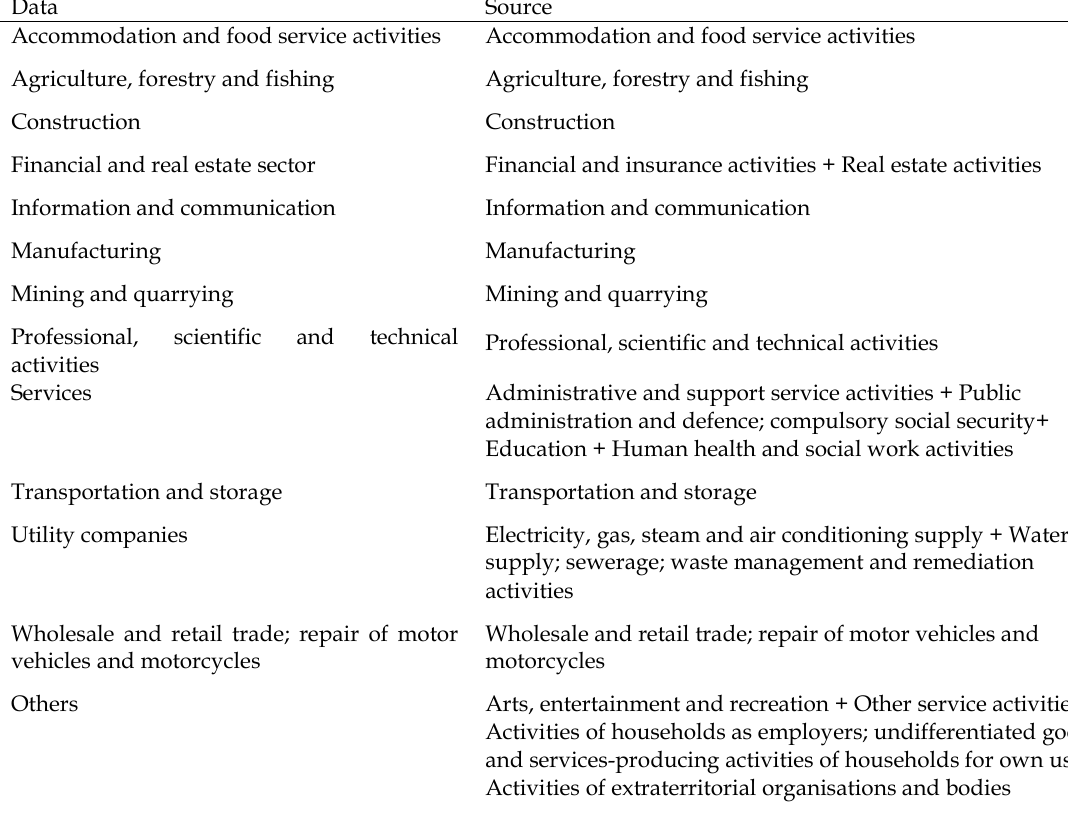
Table 2. Data overview for freight generation model.